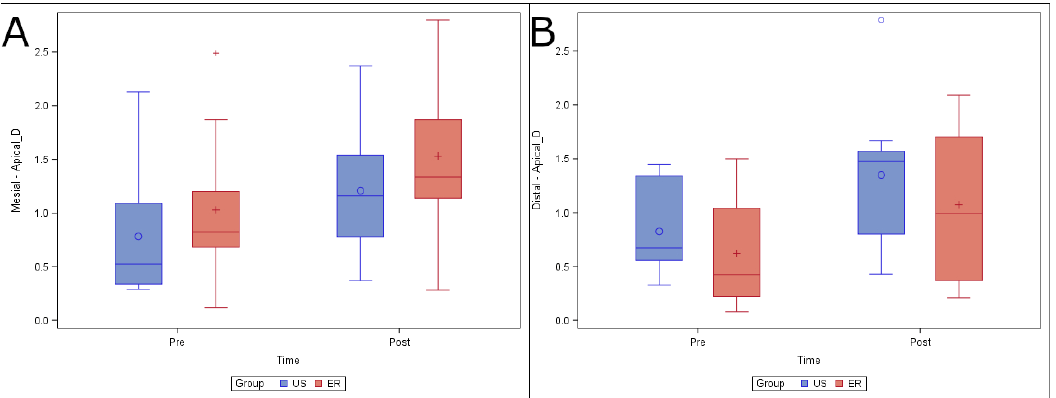
Figure 6. ( A ) Box plot of volume of dentin removed preoperatively and postoperatively, comparing the US and ER study groups at the apical level in the mesiobuccal and ( B ) distal root canal systems.